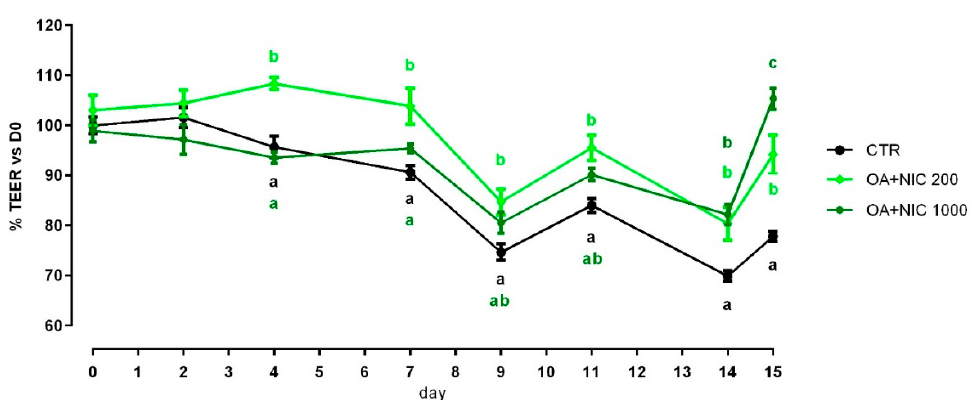
Figure 4. TEER of Caco-2 cells cultured with OA + NIC. Data in the graph are represented as percentage over the initial TEER value and given as means ( n = 6) ± SEM, represented by vertical bars. Means with different letters indicate statistical significance with p < 0.05 (a, b); means with at least one common letter are not significantly different (ab), colors of the letters refer to the different treatments. TEER = transepithelial electrical resistance ( Ω ·cm 2 ); CTR = control group; OA + NIC 200 = treated group with 200 ppm of OA + NIC, composed from 260 µM of citric acid, 298 µM of sorbic acid, 23 µM of thymol, and 13 µM of vanillin; OA + NIC 1000 = treated group with 1000 ppm of OA + NIC, composed from 1300 µM of citric acid, 1490 µM of sorbic acid, 110 µM of thymol, and 70 µM of vanillin.